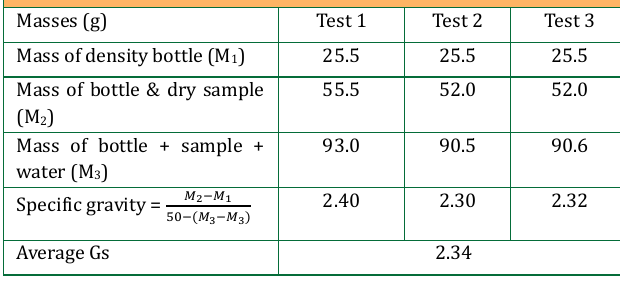
Table 3 (b): Specific Gravity Test Result for sample point 2 Masses (g)